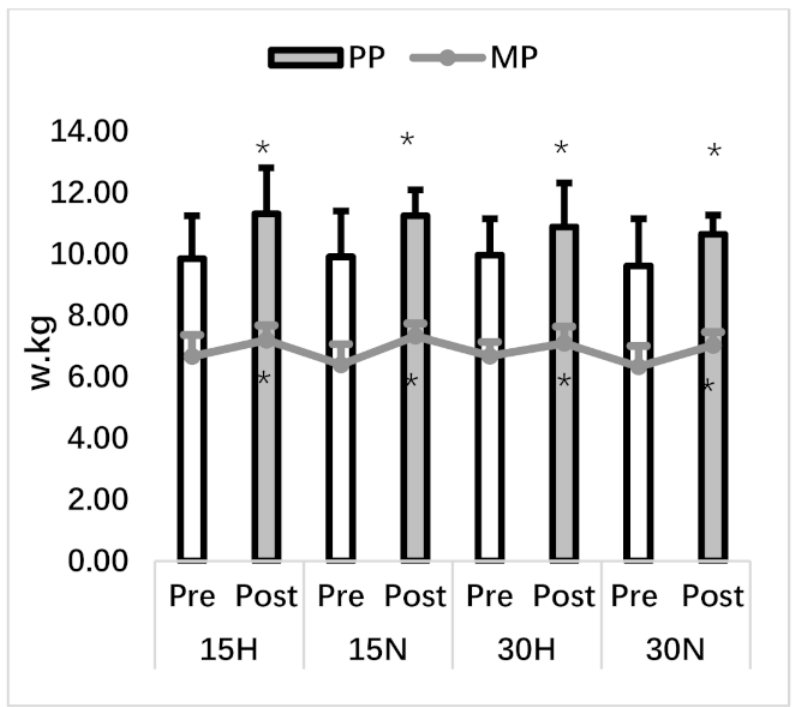
Figure 4. Repeated wingate test. PP: peak power, MP: mean power, *: significant difference between pre and post test.